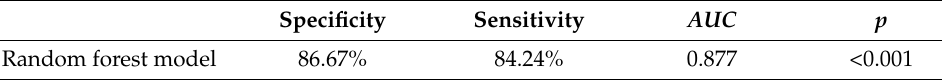
Table 8. Prediction accuracy of the random forest